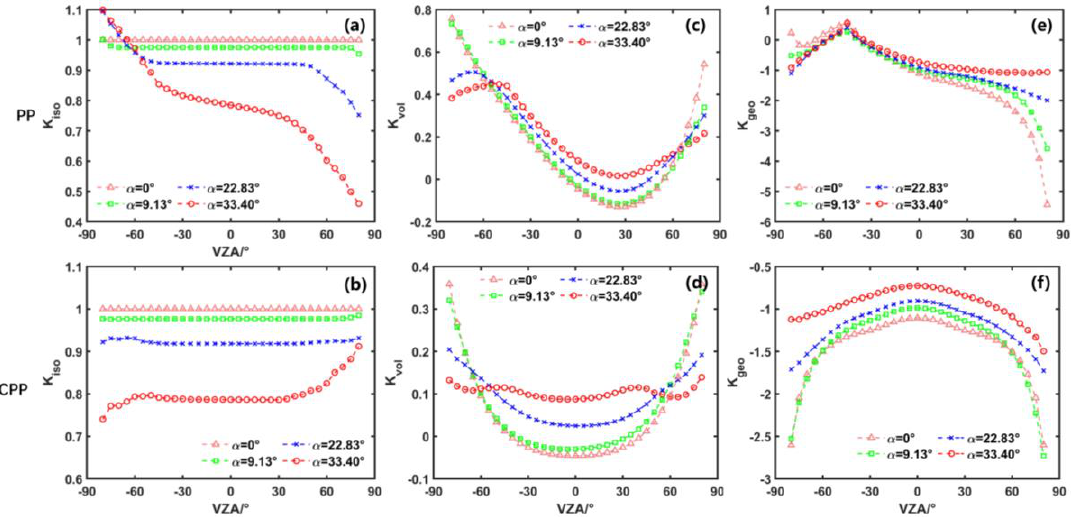
Figure 7. The kernel shape of the KDST-TCKD model in the PP and CPP under different terrain ( 𝛼 = 0°, 𝛼 = 9.13°, 𝛼 = 22.83°, and 𝛼 = 33.40°). ( a , b ) are the kernel shapes of the isotropic kernel, ( c , d ) are the volumetric − scattering kernel shapes, and ( e , f ) are the geometric – optical kernel in the PP and CPP, respectively.